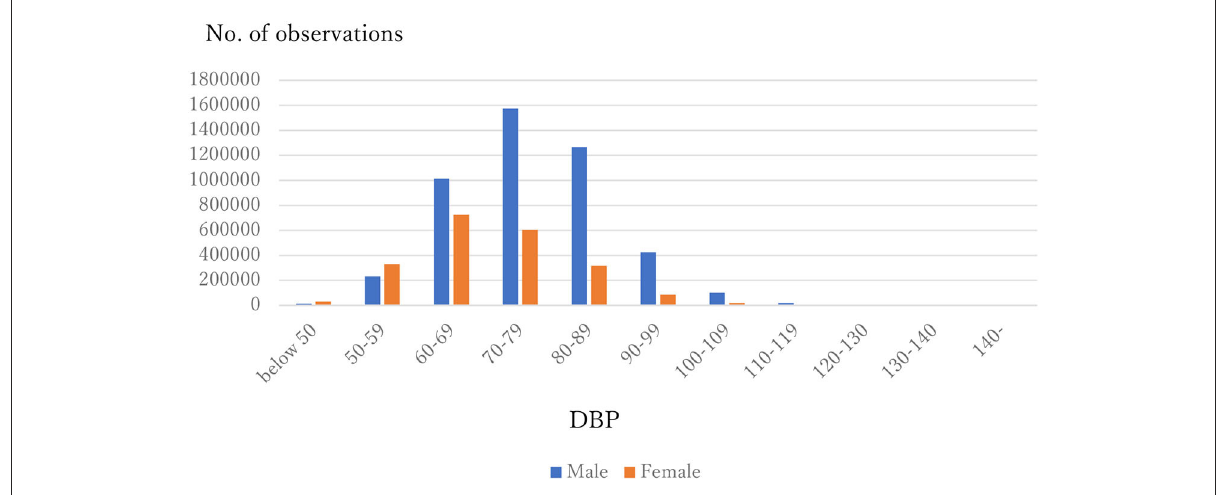
FIGURE4 Distribution of DBP by gender.